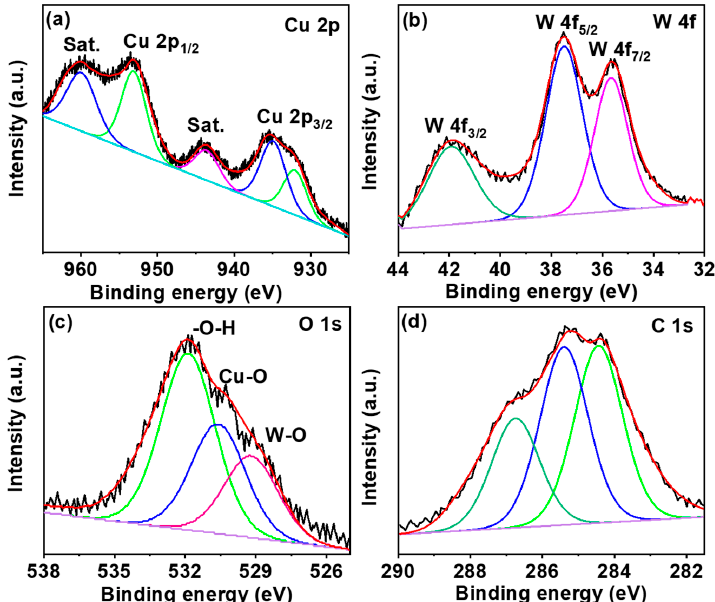
Figure 4. X-ray photoelectron spectroscopy (XPS) analysis of CuWO 4 @rGO hybrids ( a ); high- resolution Cu 2P; ( b ) W4f; ( c ) O1s; and ( d ) C1s elementals